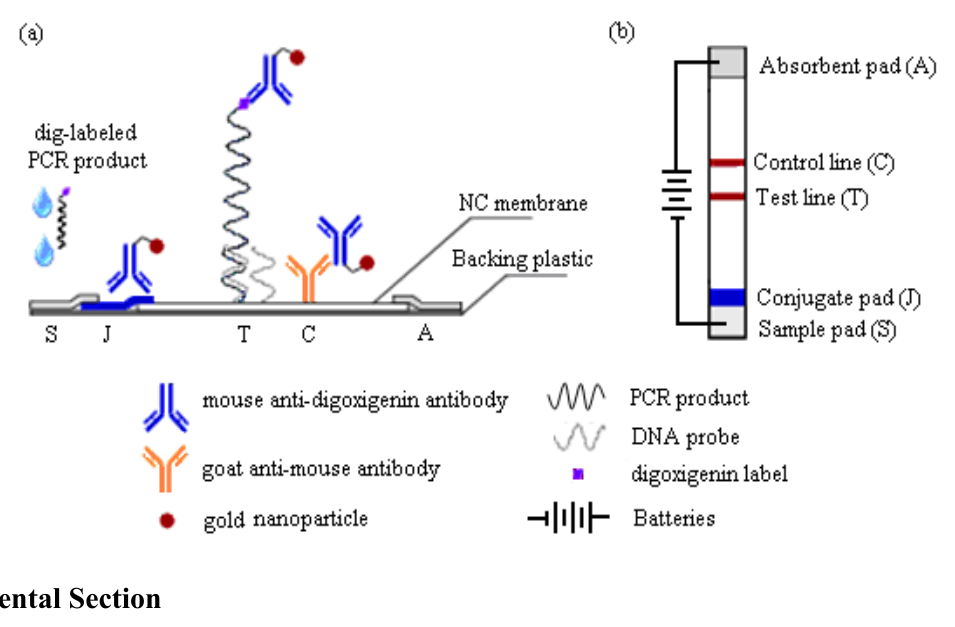
Figure 1. Assembly and assay of an electric-field enhanced MBLF strip. ( a ) Side view and ( b ) top view of the assembly. Gold tagged mouse anti-digoxigenin antibody loaded on the conjugate pad served as the reporter antibody. Rabbit anti-mouse IgG antibody served as the control